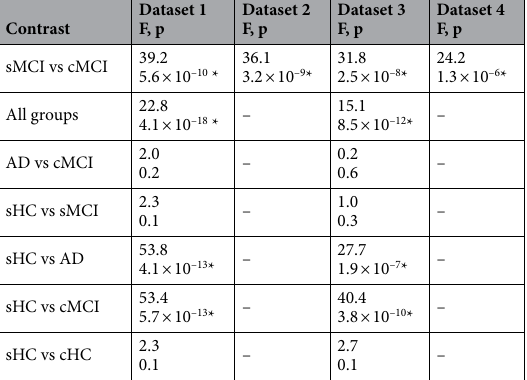
Table 4. Summary of the null hypotheses tested and results of the statistical inference. *Indicates p-value < 0.05 (Bonferroni corrected).